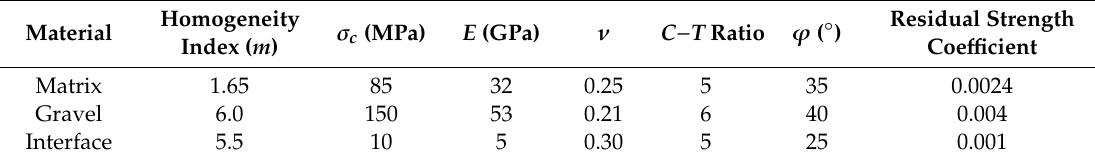
Table 4. The basic mechanical parameters for the numerical